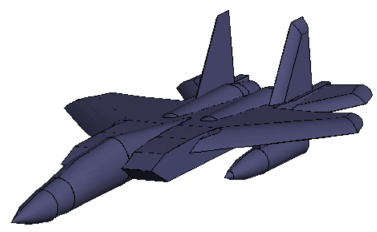
Figure 18. Side view of the model